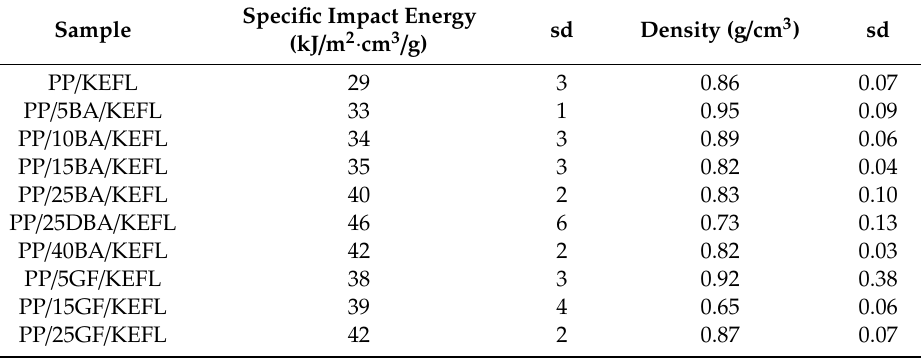
Table 5. Impact energy absorption analysis (Charpy) and density of the composites.